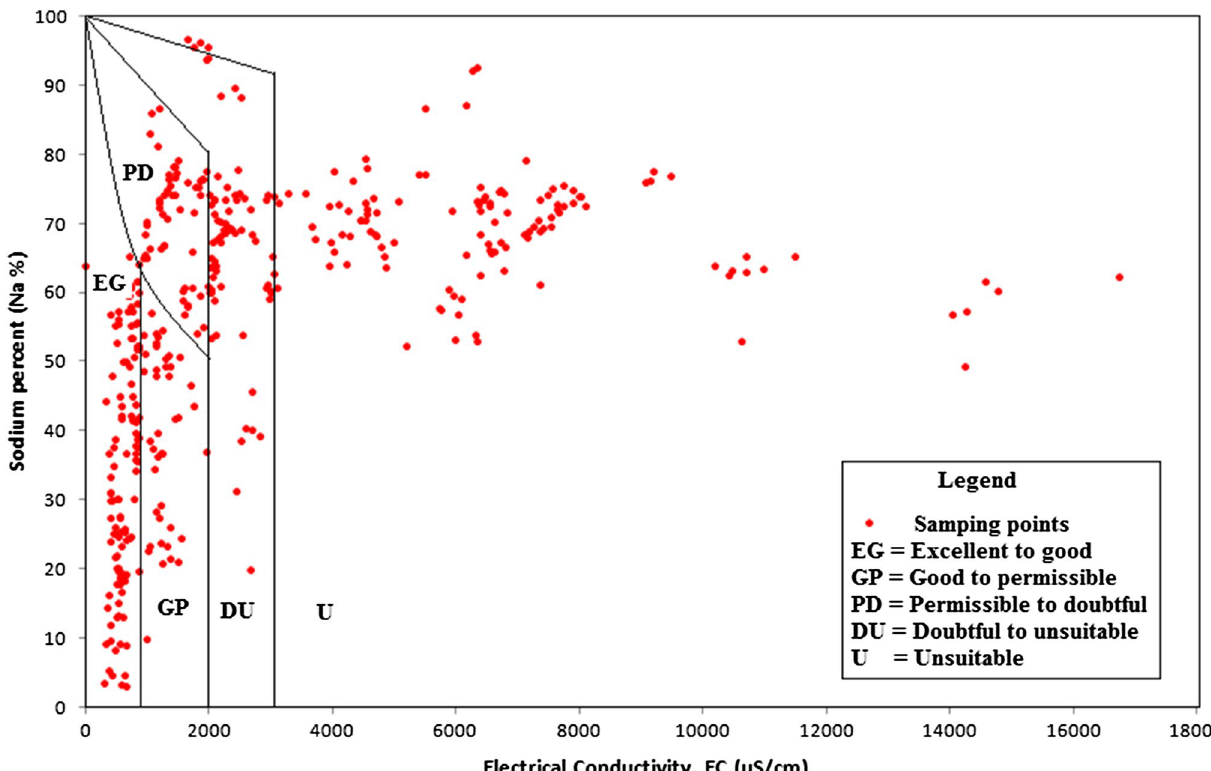
Fig. 7 Wilcox diagram irrigation samples for groundwater quality (after Wilcox